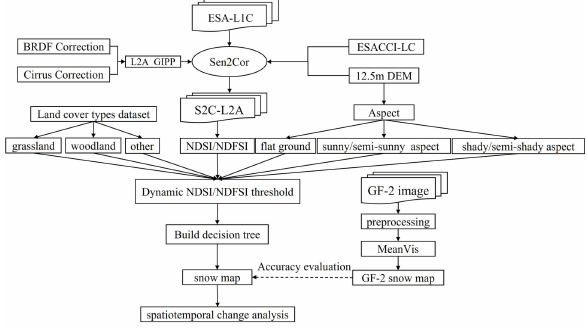
Figure 2. Flowchart of snow cover extraction in mountainous